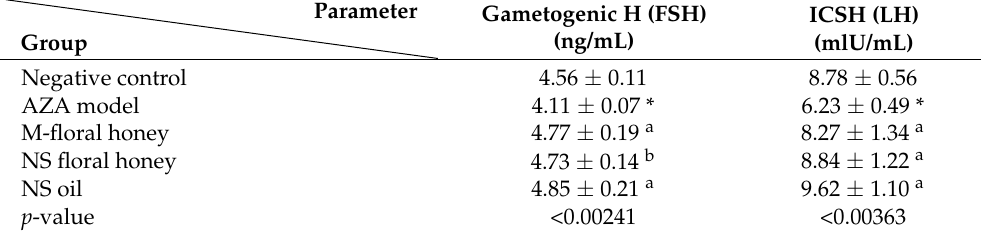
Table 3. Effects of M-floral honey, NS floral honey, and NS oil on